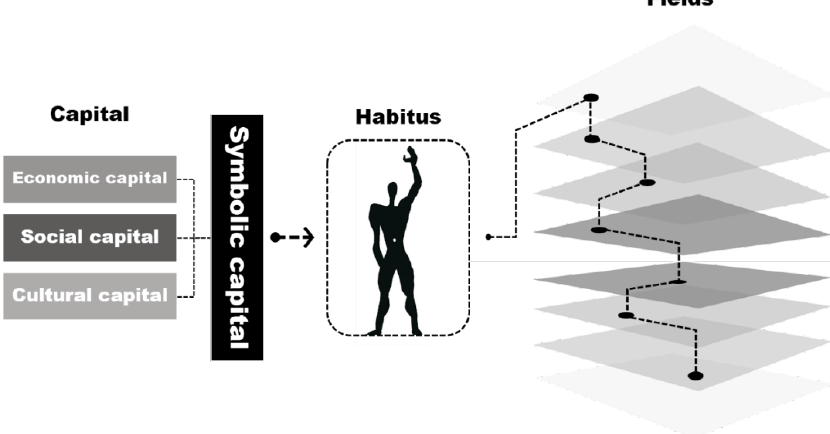
Figure 1. Bourdieu’s theory of distinction. Fields refer to different sub-spaces of society such as family groups and work groups. Individuals’ role in these fields is influenced by her symbolic capital.